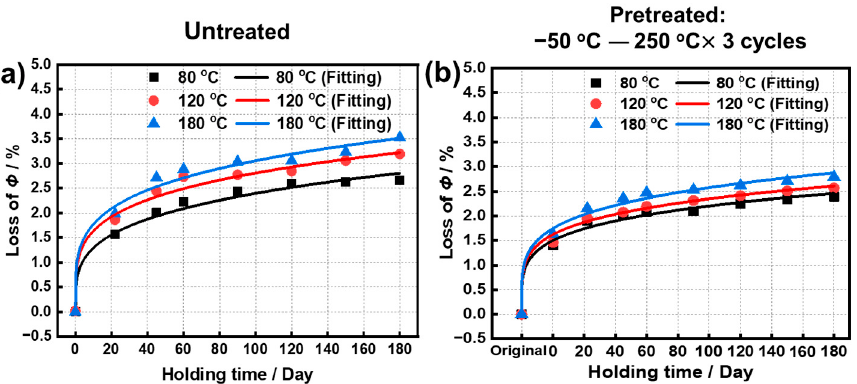
Figure 4. The Φ losses of ( a ) untreated and ( b ) pretreated samples after oxidation in air at 80, 120, and 180 °C for 180 days, respectively. Table 4. Values of fitting parameters and their standard errors ( S.E. ) in the different temperature ranges. Fitting formulae are given by Y = A × ( X − X c ) P .